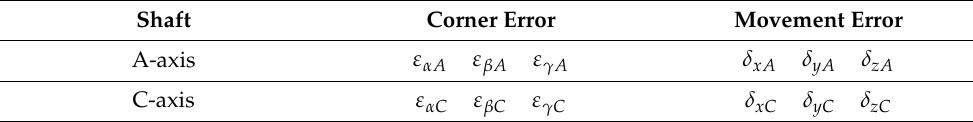
Figure 2. Machine topology and coordinate diagram. shaped specimen,